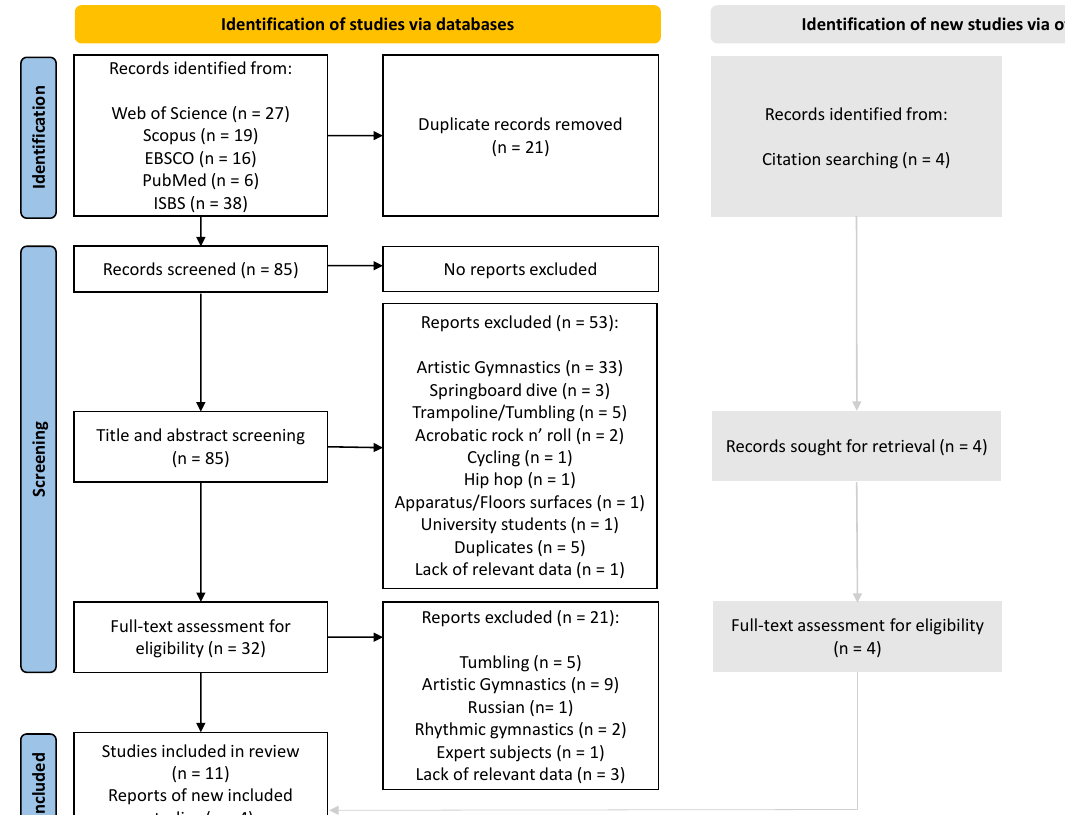
Figure 1. Document identification, screening and illegibility process.